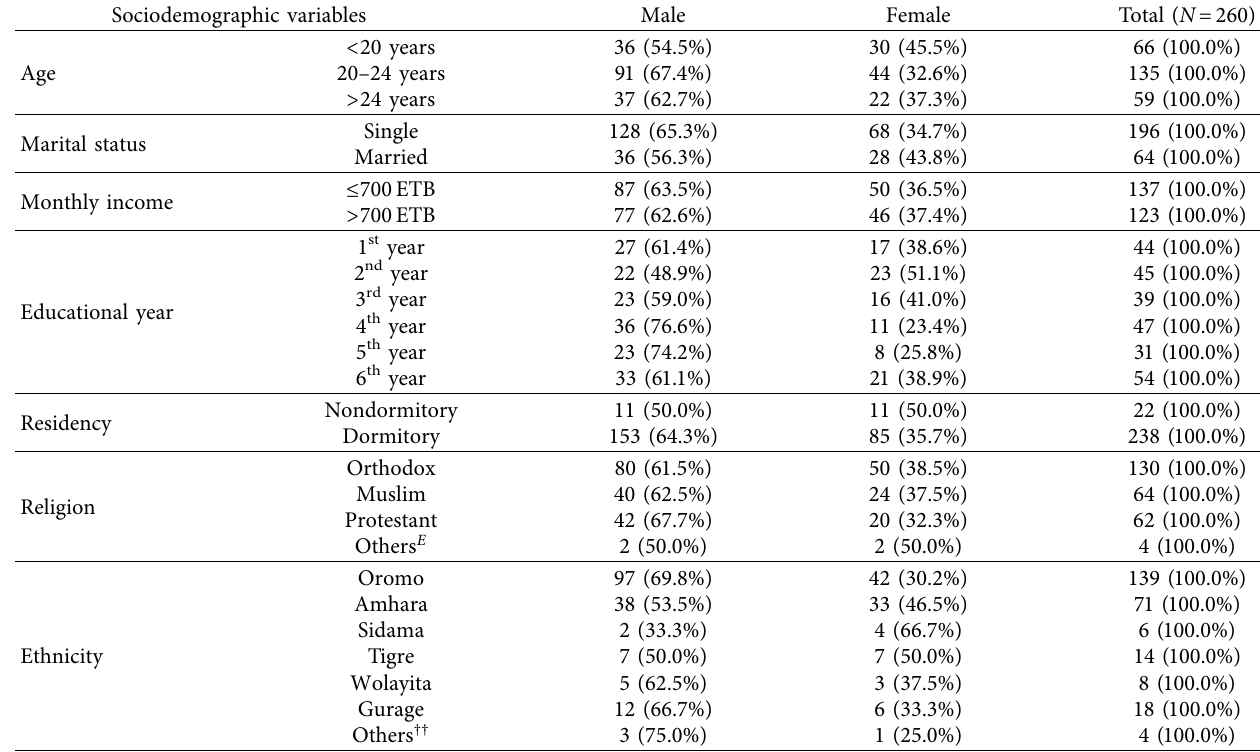
Table 2: Sociodemographic characteristics in relation to gender, N � 260, AU, January 2019. Sociodemographic variables